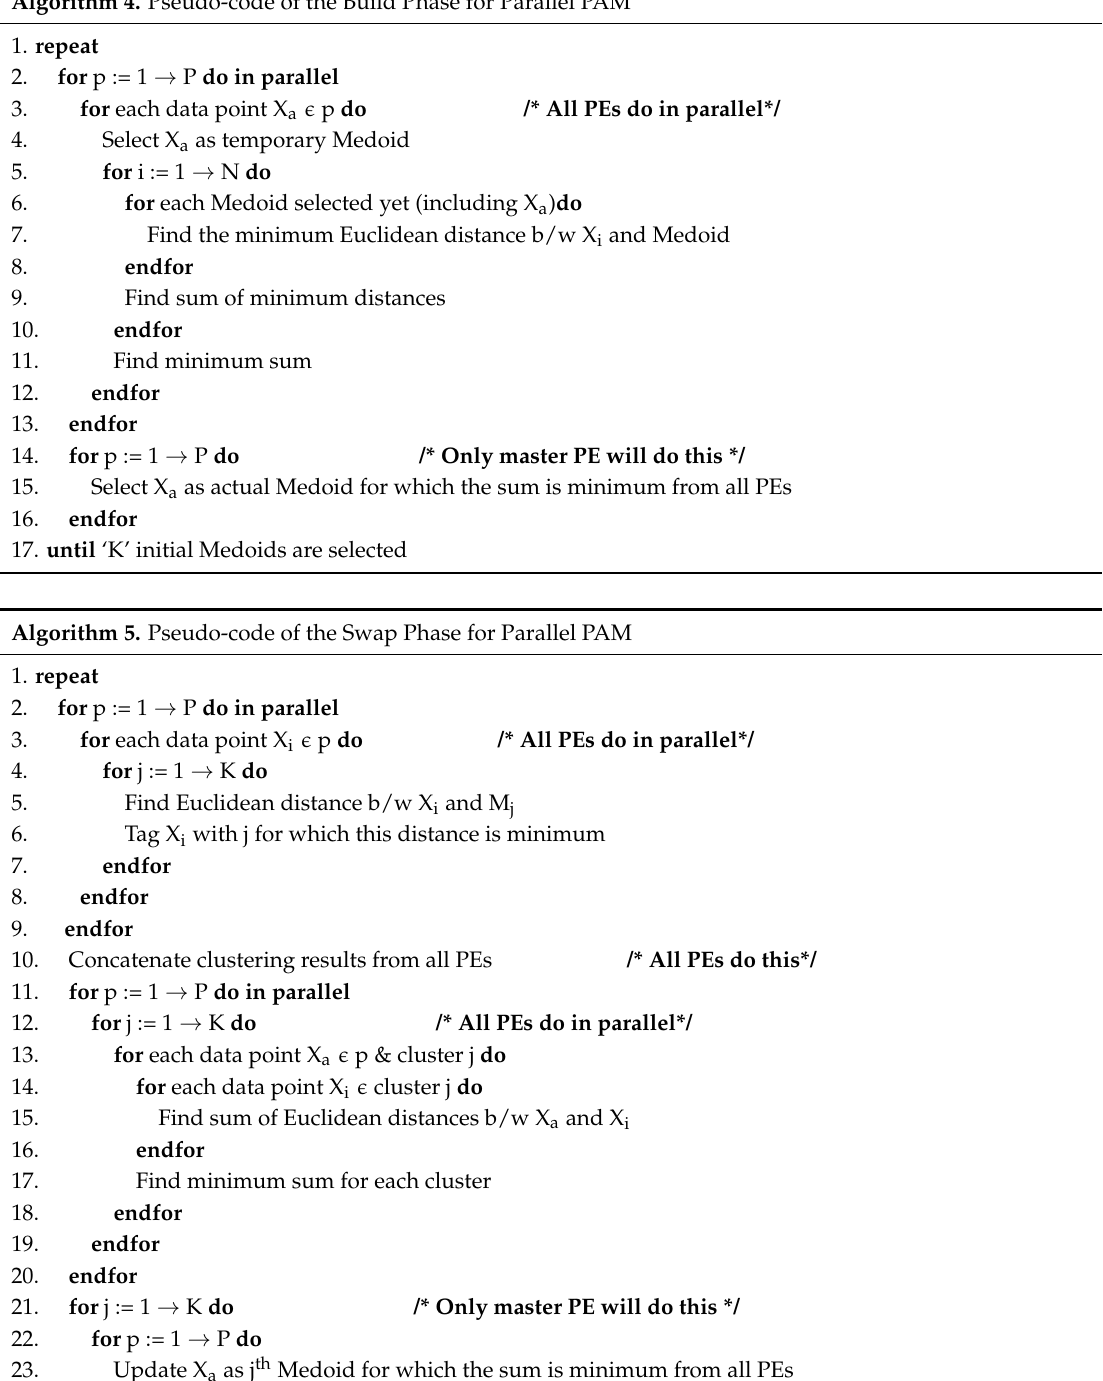
Algorithm 4. Pseudo-code of the Build Phase for Parallel PAM